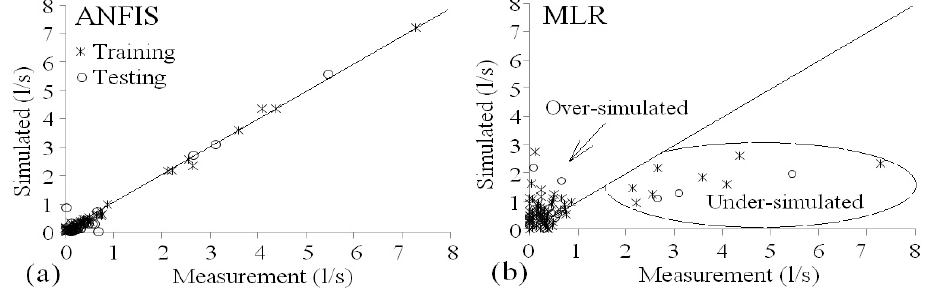
Figure 6. Comparing the results of adaptive neural-based fuzzy inference system (ANFIS) and multiple linear regression (MLR) models versus the observations (testing set of 1st